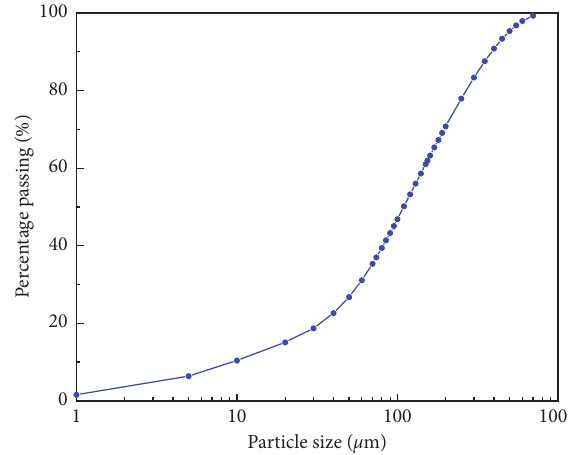
Figure 1: The particle size distribution of classified